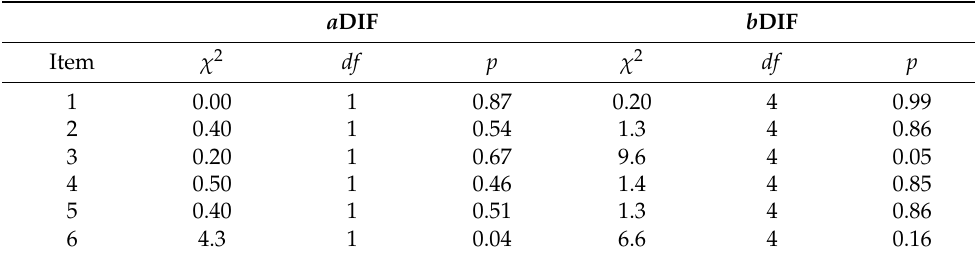
Table 3. Differential item functioning (DIF) of discrimination and severity parameters across gender. a DIF b DIF Item